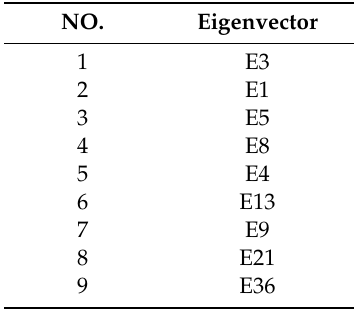
Table 4. Variables contained in the ESFLR model and their coefficients.